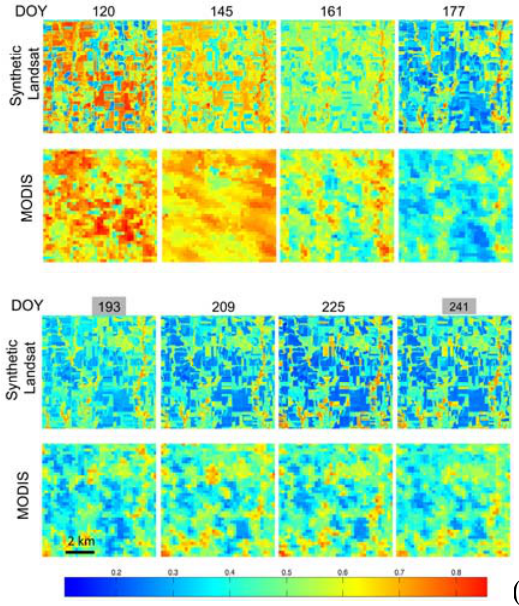
Figure 6. ( A ) Time series of NDVI image subsets (9 km × 9 km) from the MODIS NDVI (MOD13Q1) and combined mode Kalman simulation NDVI images for the Kansas site. The time series includes eight 16-day periods starting in early May (DOY 120) and finishing in late August (DOY 241). The dates in grey indicate the time steps for which Landsat images were used as model observations. ( B ) Time series of NDVI image subsets (48 km × 48 km) from the MODIS NDVI (MOD13Q1) and combined mode Kalman simulation NDVI images for the Mozambique site. The time series includes four 16-day periods starting in June (DOY 193) and finishing in late September (DOY 241). The date in grey indicates the time steps for which a Landsat image was used as the model